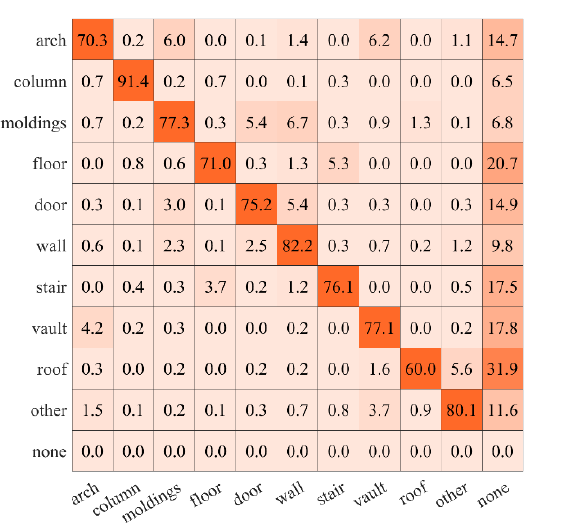
Figure 5 . Confusion Matrix for 1_SC back-projection.